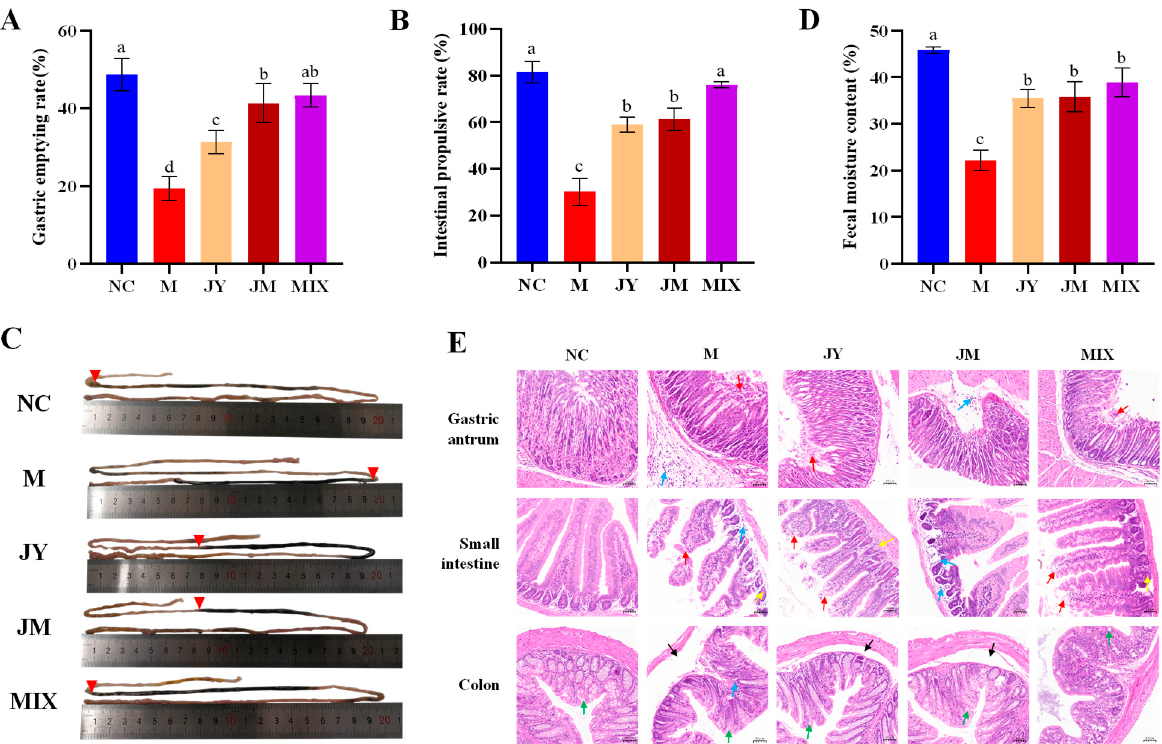
Figure 1. Alleviation of gastrointestinal (GI) motility disorder of probiotics: ( A ) change of gastric emptying rate in mice; ( B ) change of small intestinal propulsive rate in mice; ( C ) specifics of ink propulsion in the small intestine; ( D ) change of fecal moisture content in mice; ( E ) hematoxylin and eosin (HE) staining for gastric antrum, small intestine and colon sections (200×). Different letters (a, b, c and d) denote significant differences between different groups of mice ( p < 0.05). NC stands for the normal control group, M for the model group, JY for the L. paracasei JY062 group, JM for the L. gasseri JM1 group, and MIX for the combination group. Red trangles in ( C ) stand the front end of the ink, and different color arrows in ( E ) denote eroded and shed mucosal epithelial cells (red arrows), inflammatory cells (blue arrows), submucosal edema (black arrows), Paneth cells (yellow arrows) and goblet cells (green arrows).